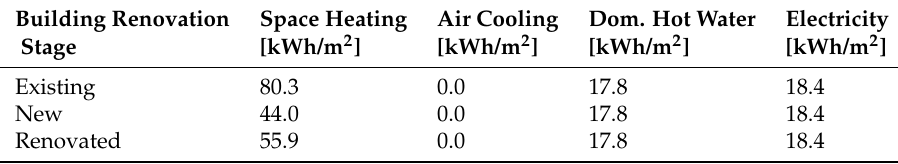
Table A20. Yearly specific energy service demand of residential MFH